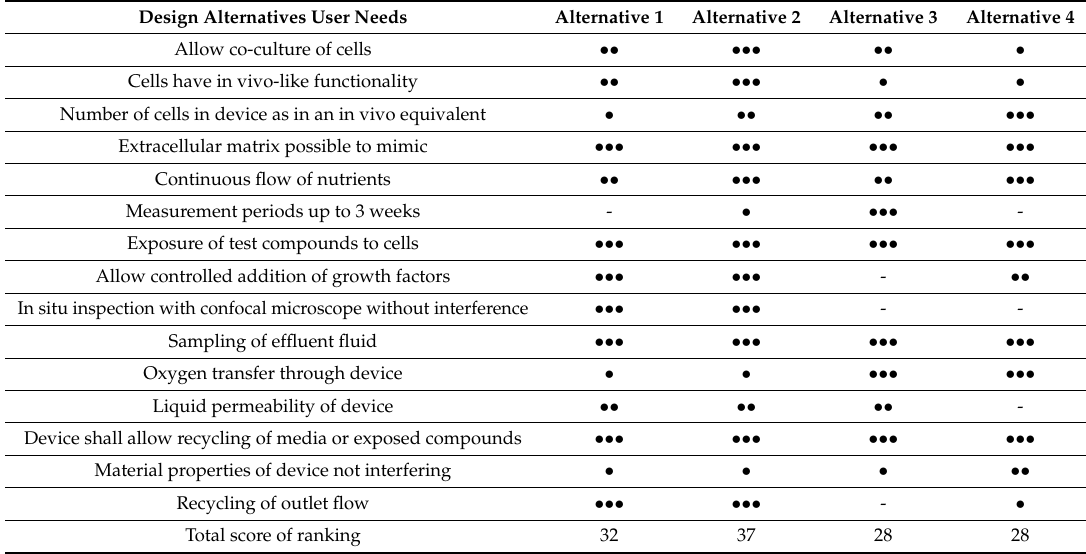
Table 3. Example of ranking of design alternatives versus target specification metrics 1